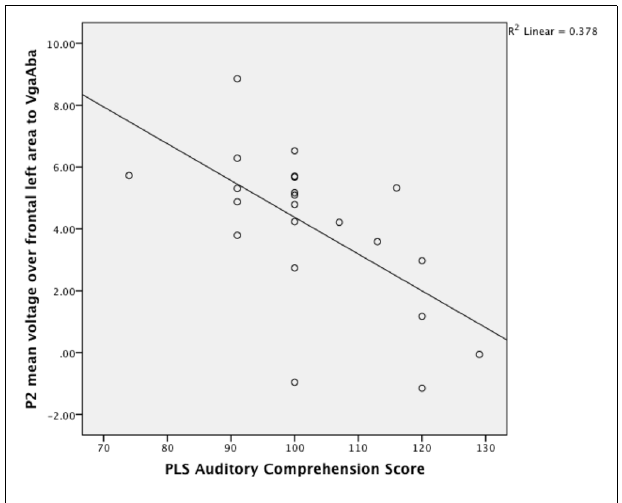
FIGURE 2 |A scatterplot showing the relationship between the mean P2 voltage over the left frontal area (140–240 ms) in response to VgaAba at 6–9 months of age and PLS auditory comprehension scale at 14–16 months.